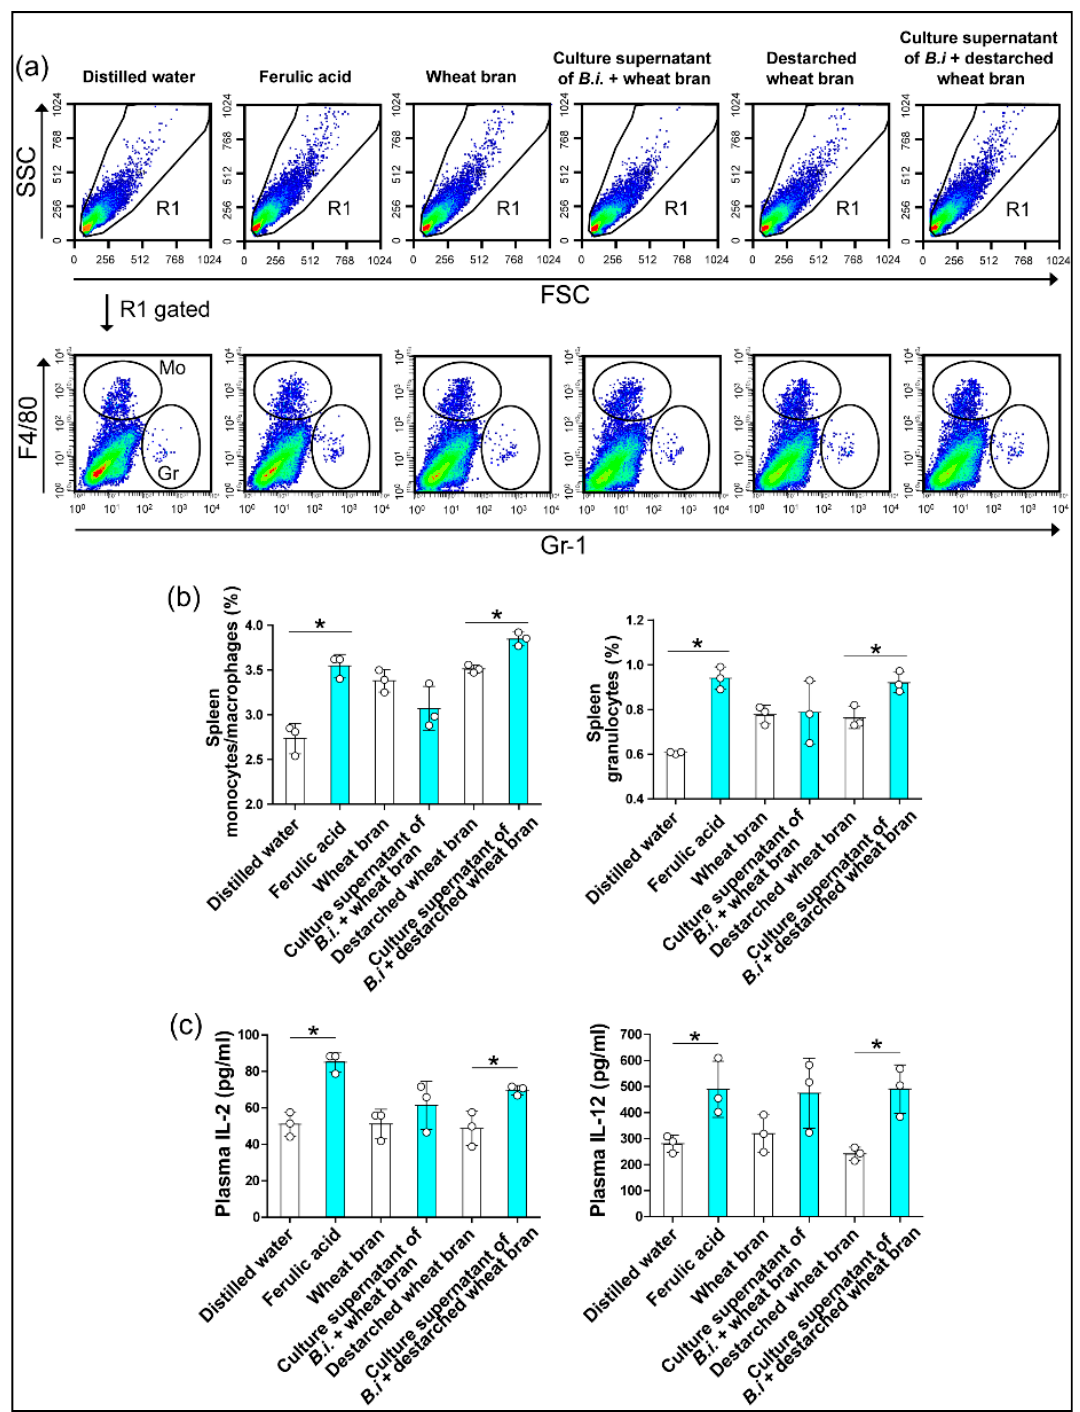
Figure 4. The culture supernatant from Bacteroides intestinalis increased monocytes/macrophages and granulocytes in the spleen under physiological conditions. Flow cytometry analyses demonstrated an increased percentage of mono- cytes/macrophages and granulocytes in the spleen ( a , b ) from healthy mice treated with ferulic acid or a culture supernatant of Bacteroides intestinalis (B.i) + destarched wheat bran. Enzyme immunoassays showed increased circulating levels of IL-2 and IL-12 in healthy mice treated with ferulic acid and culture supernatant from Bacteroides intestinalis grown on destarched wheat bran ( c ). The results are shown as the mean ± S.D. of one experiment. Three mice in each treatment group. Each dot represents one mouse. Statistical analysis was performed using the Mann–Whitney U test. * p < 0.05. SSC, side scatter; FSC, forward scatter.